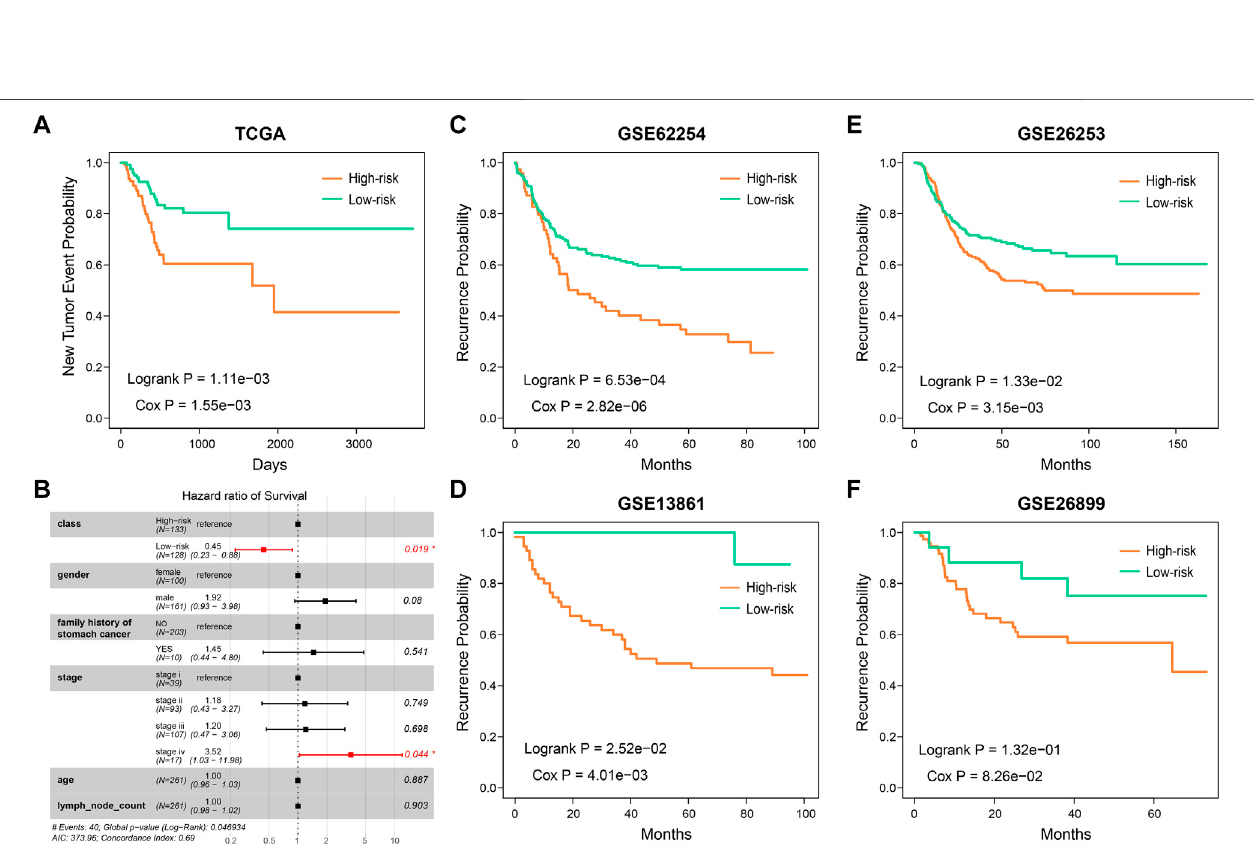
FIGURE 4 | The predictive ability of SSA-NHEJ score for recurrence of GC patients. (A) New Tumor Event probability of patients in TCGA cohort. (B) Multivariate Coxproportional-hazardsregressionresultforrecurrenceprognosisoftheSSA-NHEJscoreandotherclinicalcharacteristics. (C – F) Recurrenceprobabilityofpatientsin four GEO